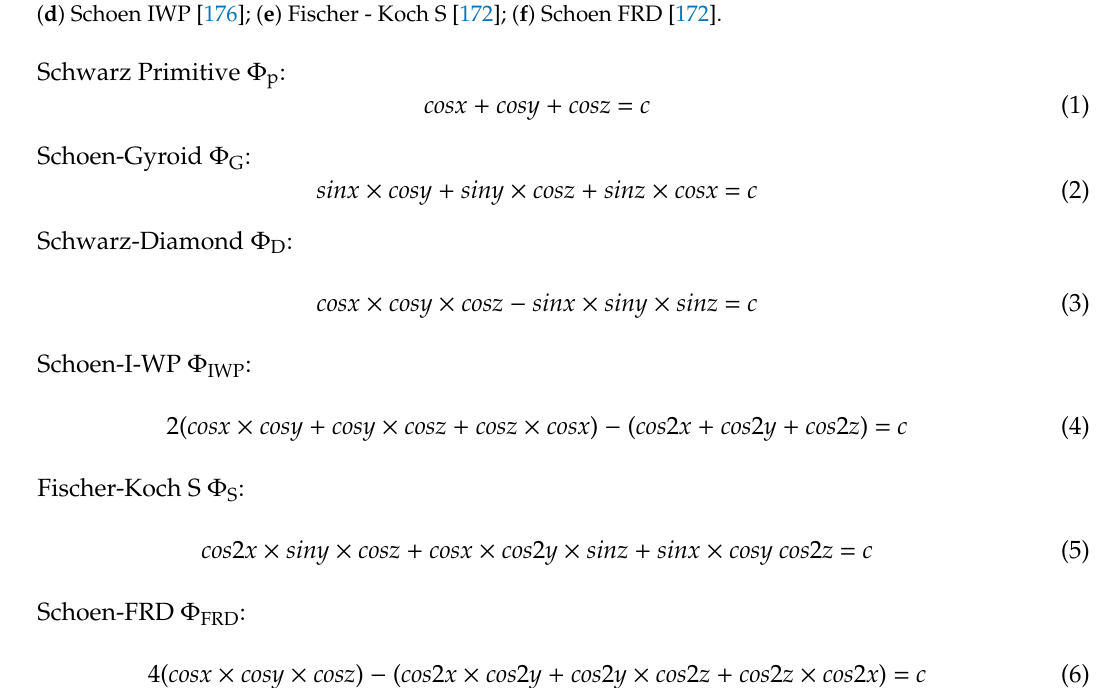
Figure 14. Unit cell based on TPMS: ( a ) Schwartz P [176]; ( b ) Schoen G [176]; ( c ) Schwarz D [176]; ( d ) Schoen IWP [176]; ( e ) Fischer - Koch S [172]; ( f ) Schoen FRD [172].